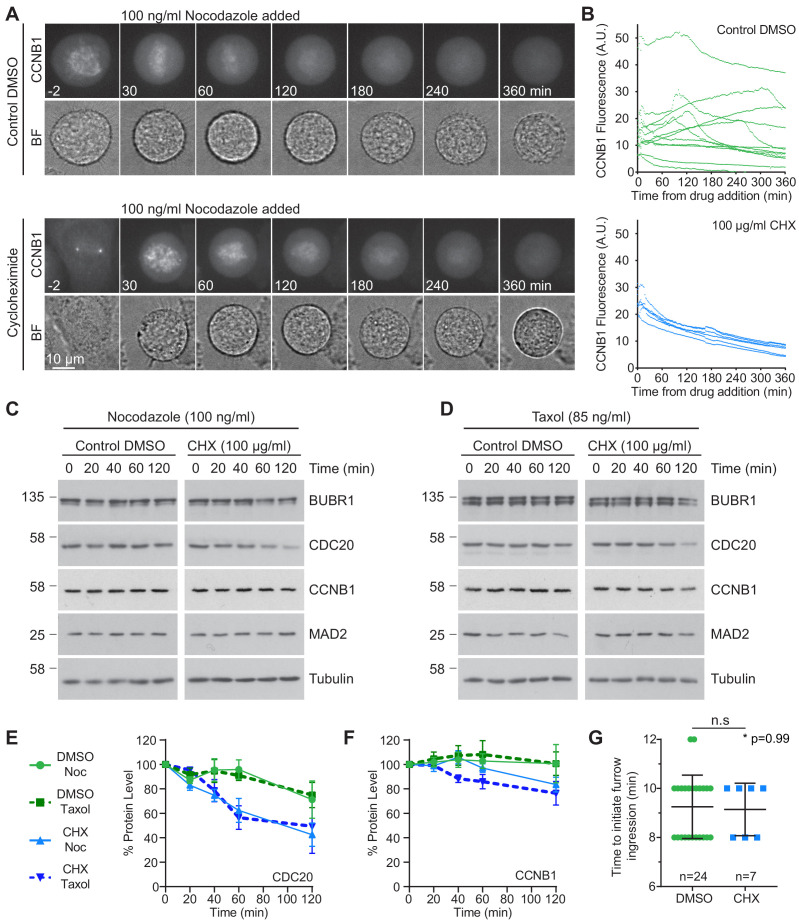
Ongoing protein synthesis is not required to maintain spindle assembly checkpoint-dependent arrest during mitosis.(A) Live cell imaging of endogenously CRISPR-tagged CCNB1, following addition of 100 ng/ml nocodazole with either DMSO as a control or 100 µg/ml cycloheximide (CHX). (B) Raw fluorescence intensity plot of cells over time after drug addition (DMSO n = 12, CHX n = 6, from a single experiment). Only cells which enter mitosis are shown on the graph. Images shown are sum intensity projections, quantification was carried out on sum intensity projections. All times shown are relative to the point of drug addition. (C–D) Cells were arrested in mitosis using (C) nocodazole or (D) taxol, prior to the addition of either DMSO or 100 µg/ml CHX, to inhibit protein synthesis. Changes in protein level were then followed by western blot. Densitometric quantification of western blot data from (C–D) for (E) CDC20 or (F) CCNB1 (Mean ± SEM, n = 3). (G) Statistical analysis of the time taken for cells from Figure 4A to initiate cleavage furrow ingression following chromosome separation using a Mann-Whitney test, * denotes the calculated p-value.